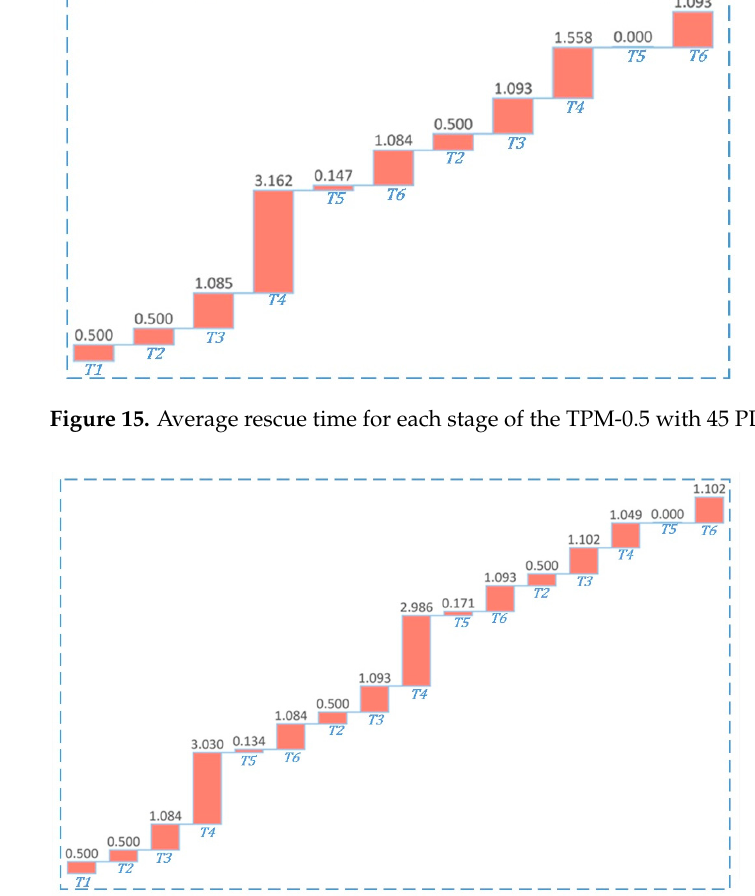
Figure 16. Average rescue time for each stage of the TPM-0.5 with 70 PDTs.